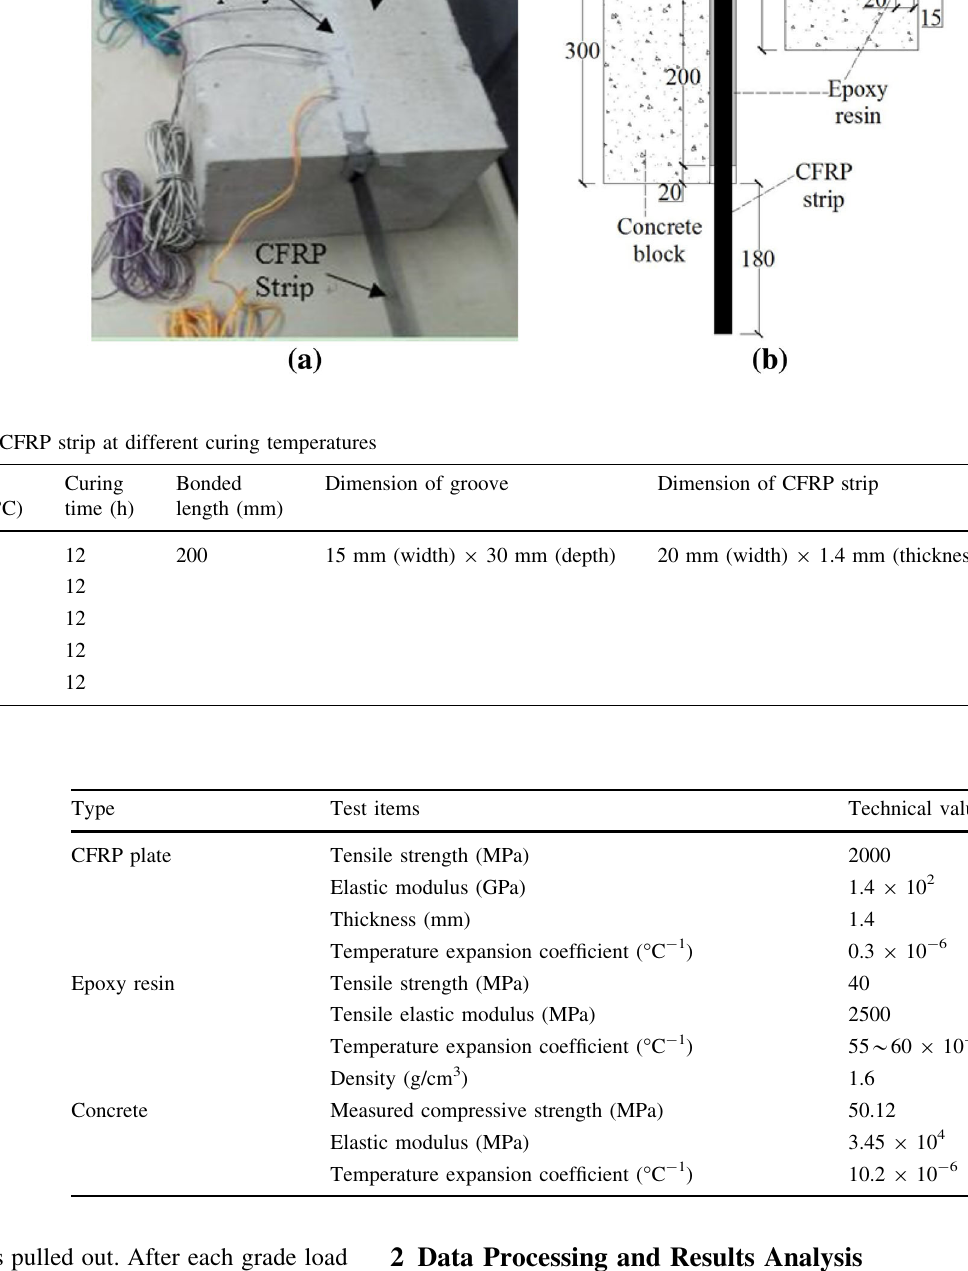
Fig. 1 Schematic of specimen. a Single shear pull-out specimen, b dimension of specimen